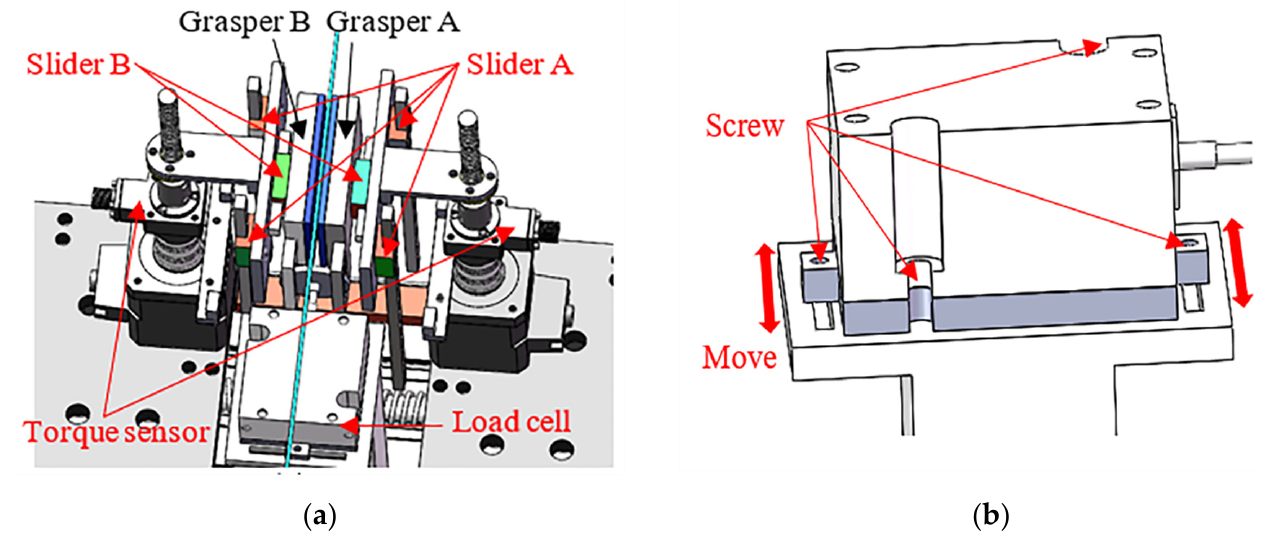
Figure 8. Design of the force detection structure. ( a ) Detailed drawing of force measuring device; ( b ) loadcell installation location.